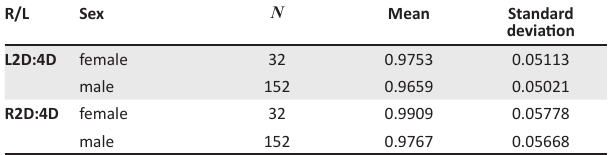
TABLE 1: Mean 2D:4D of male and female